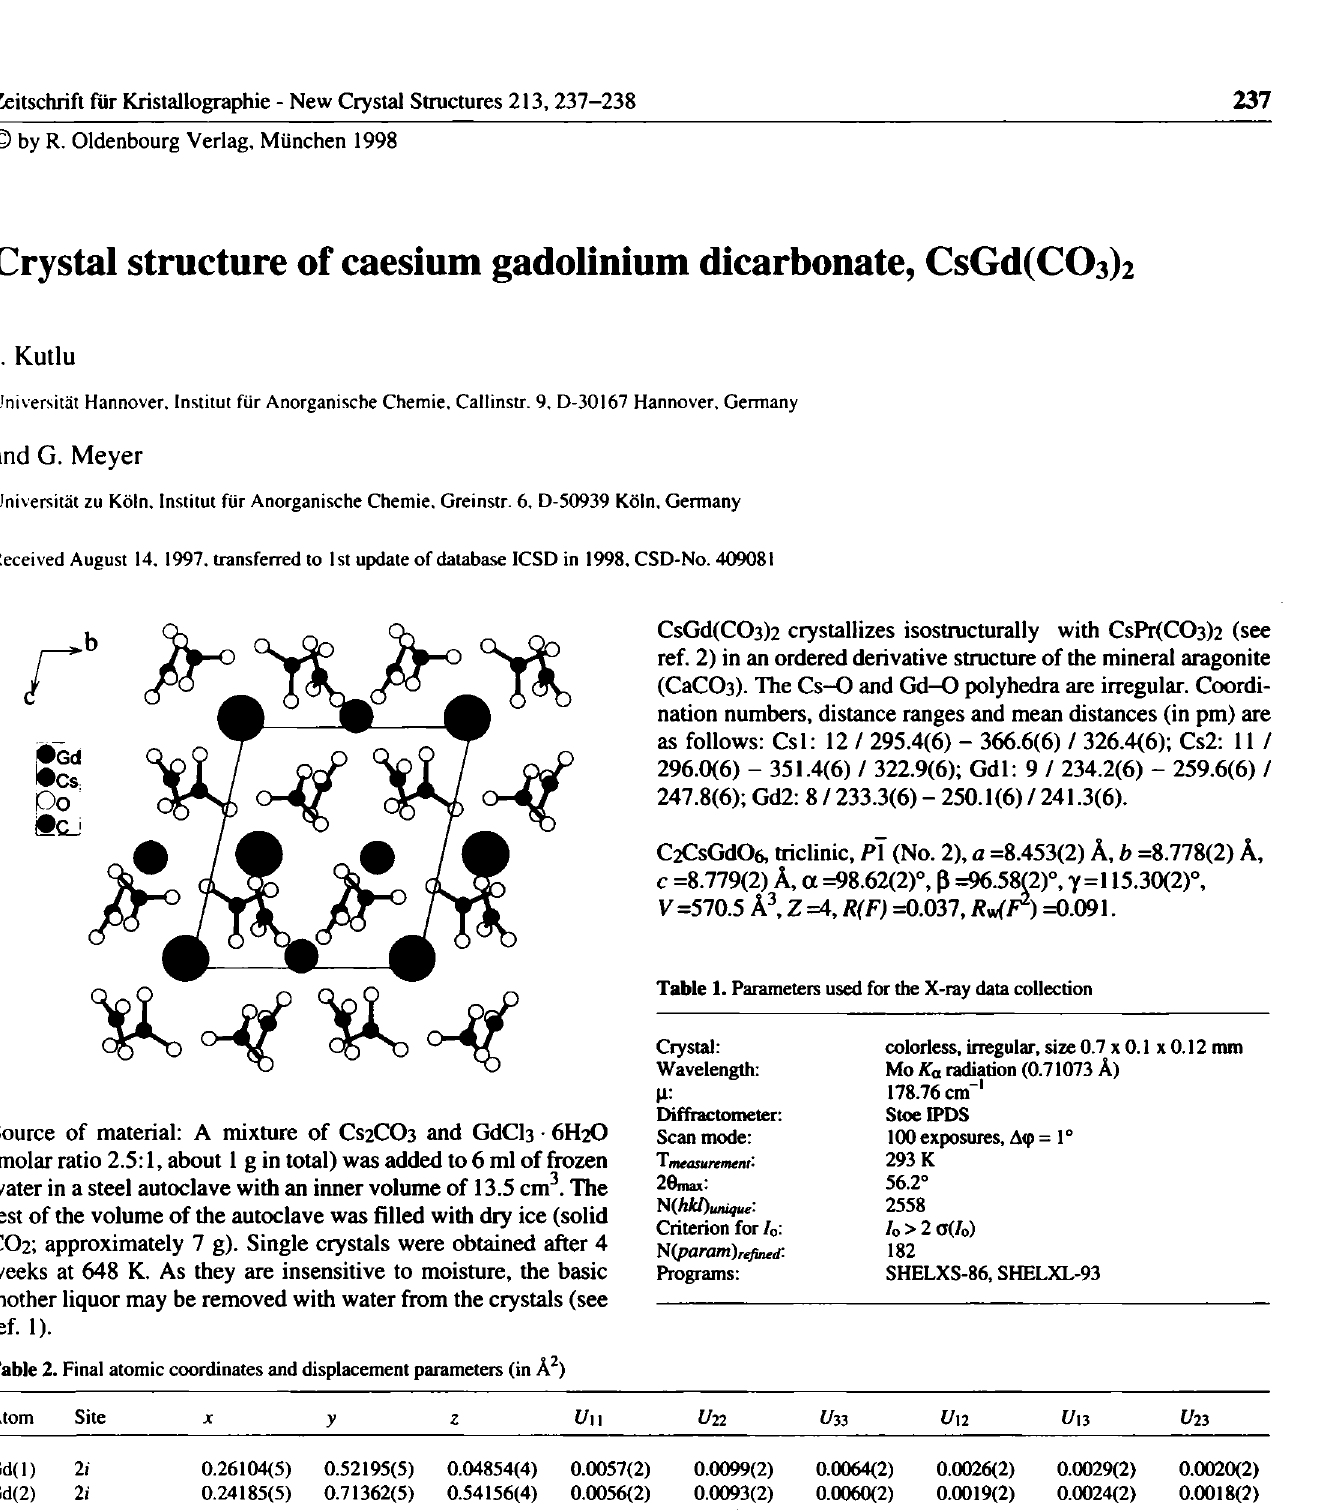
Table 2. Final atomic coordinates and displacement parameters (in Â^)